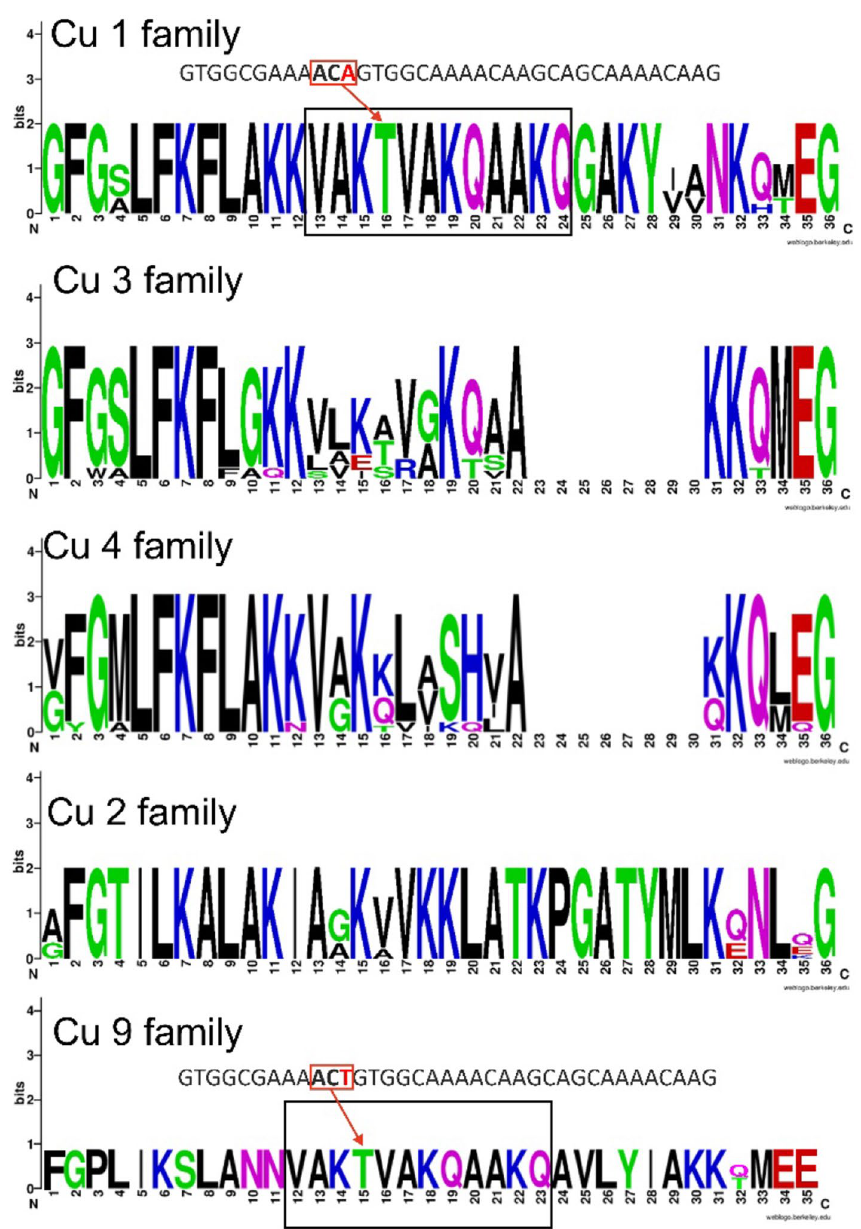
Figure 4. Amino acid sequence logos of related cupiennin families. The relative frequency of each amino acid residue at a certain position of different cupiennin families is given as sequence logo. Cationic amino acids are colored in blue, anionic amino acids in red, the corresponding C-terminal amid variants in pink, polar amino acids in green, and hydrophobic amino acids in